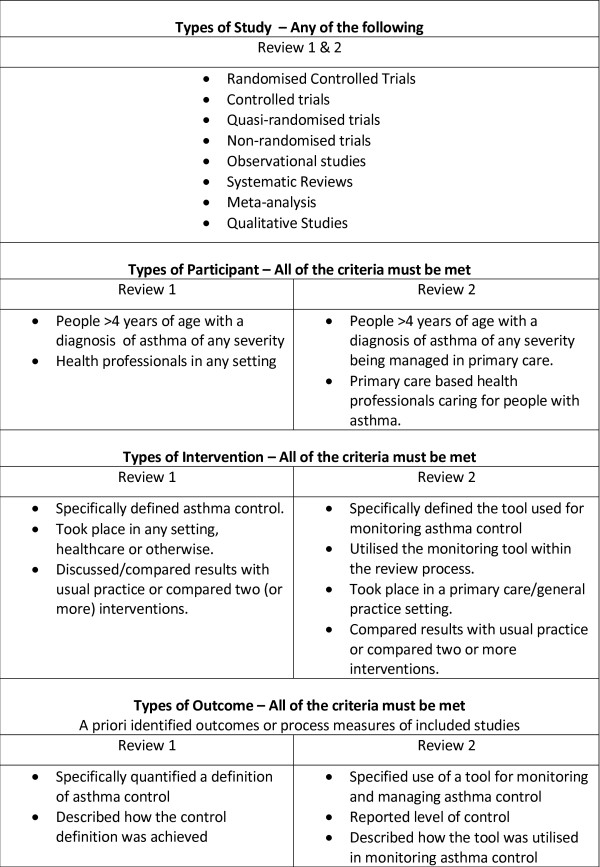
Inclusion criteria for studies in the systematic review.